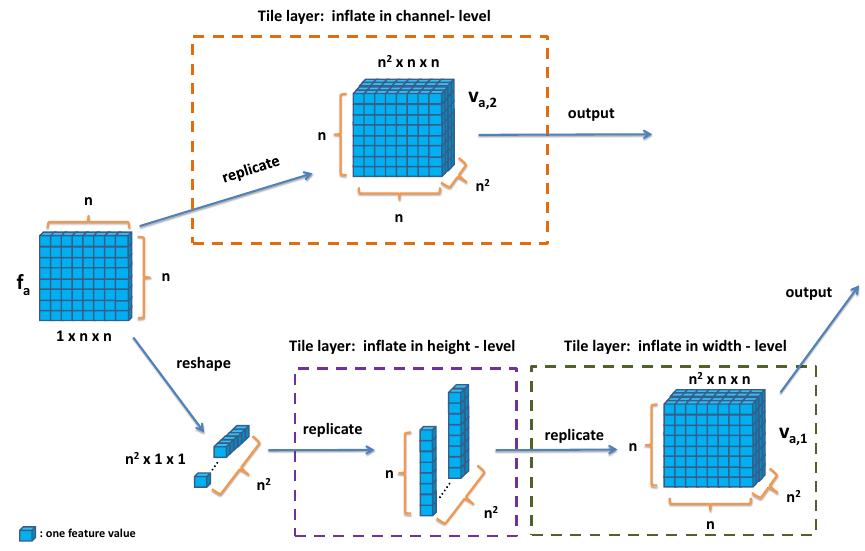
Figure 3. The process of transforming f a to v a ,1 and v a ,2 in the tile